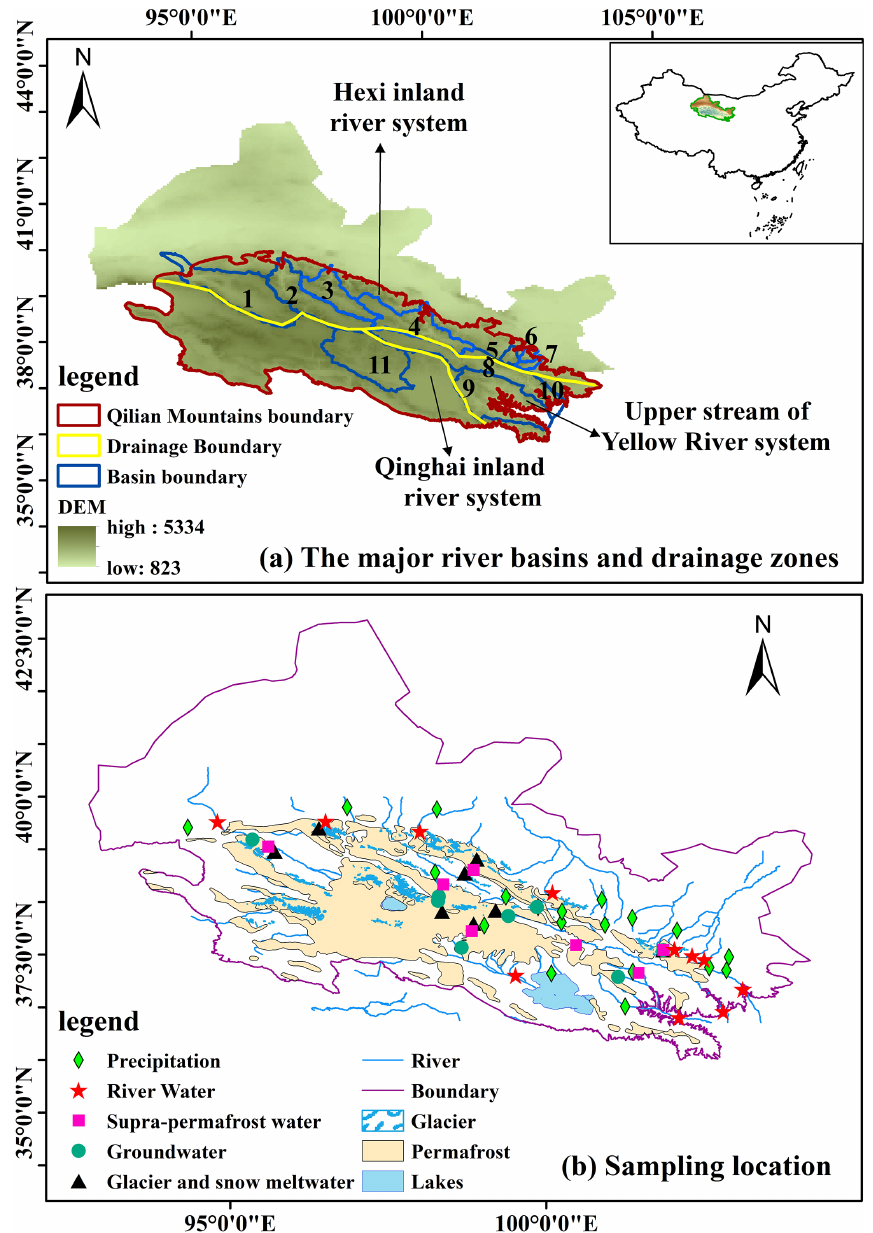
Figure 1. Location of (a) study region (1. Danghe River, 2. Changma River, 3. Taolai River, 4. Heihe River, 5. Xiying River, 6. Nanying River, 7. Zamu River, 8. Datong River, 9. Huangshui River, 10. Jinqiang River, 11. Buha River) and (b) sampling